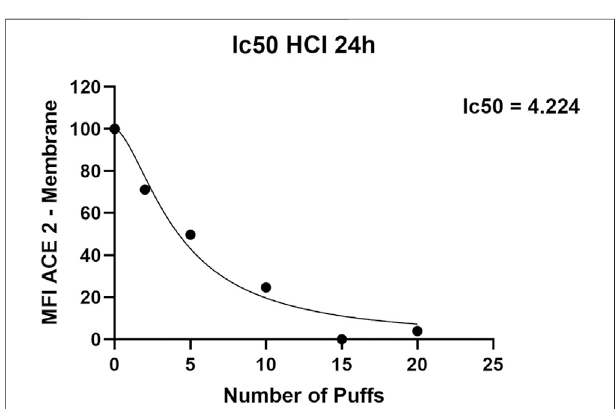
FIGURE 2 | IC50 ( half maximal inhibitory concentration) curve for ACE-2 expression obtained with increasing puff number of 1R6F smoked under HCI (Health Canada Intense) regime on H292 cells at Air-Liquid Interface